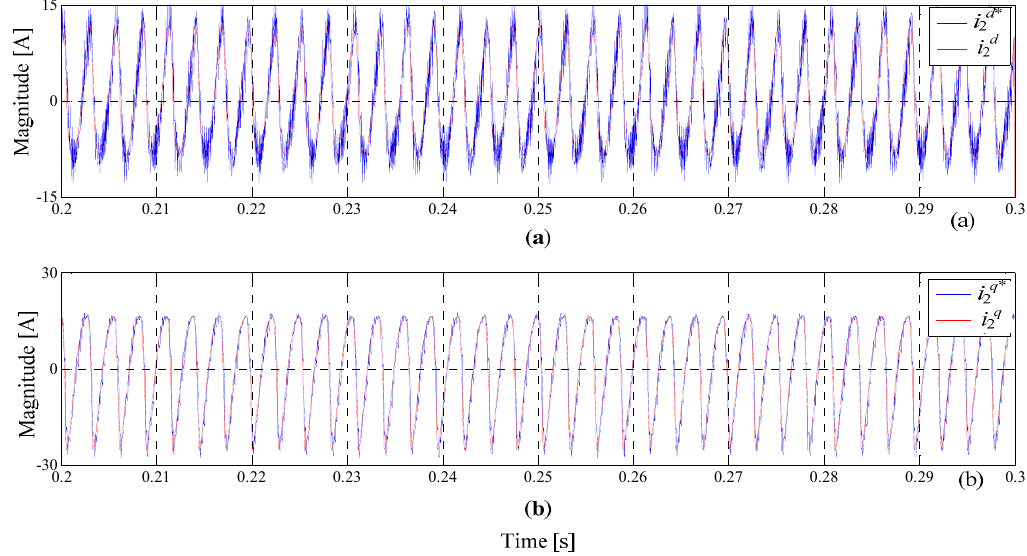
Figure 11. dq control components for the BTB-VSC when it compensates active and reactive power and the current harmonics: ( a ) i 2d (blue) and its reference i 2d * (red). ( b ) i 2q (red) and its reference i 2q * (blue).